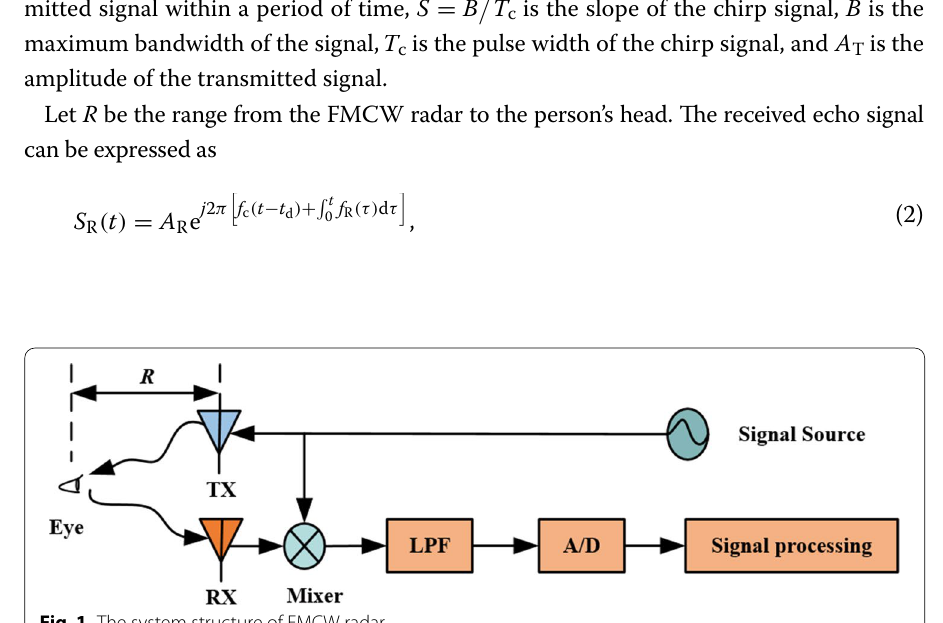
Fig. 1 The system structure of FMCW